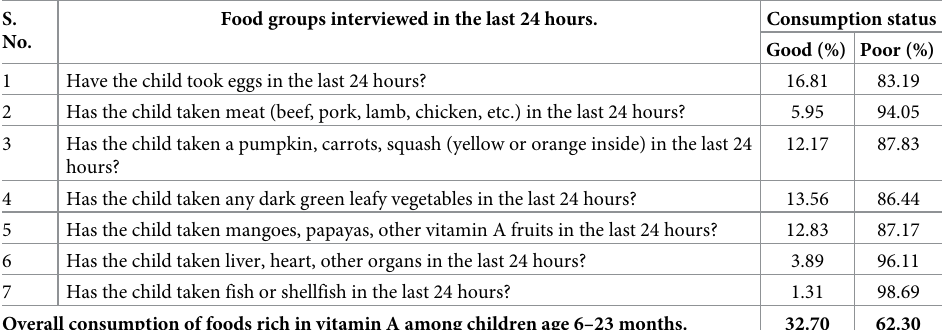
Table 2. Consumption of foods rich in vitamin A among children aged 6–23 months in the last 24 hours preced- ing survey EDHS, 2016, Ethiopia (n = 3055). S. Food groups interviewed in the last 24 hours. No.